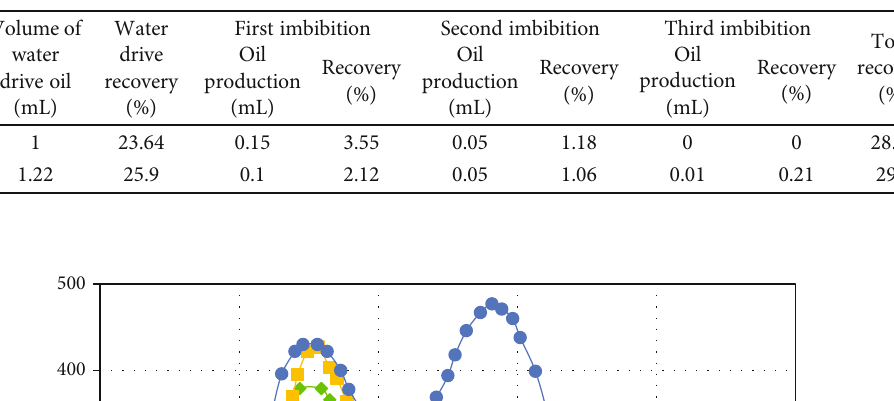
Table 3: Core dynamic imbibition data.